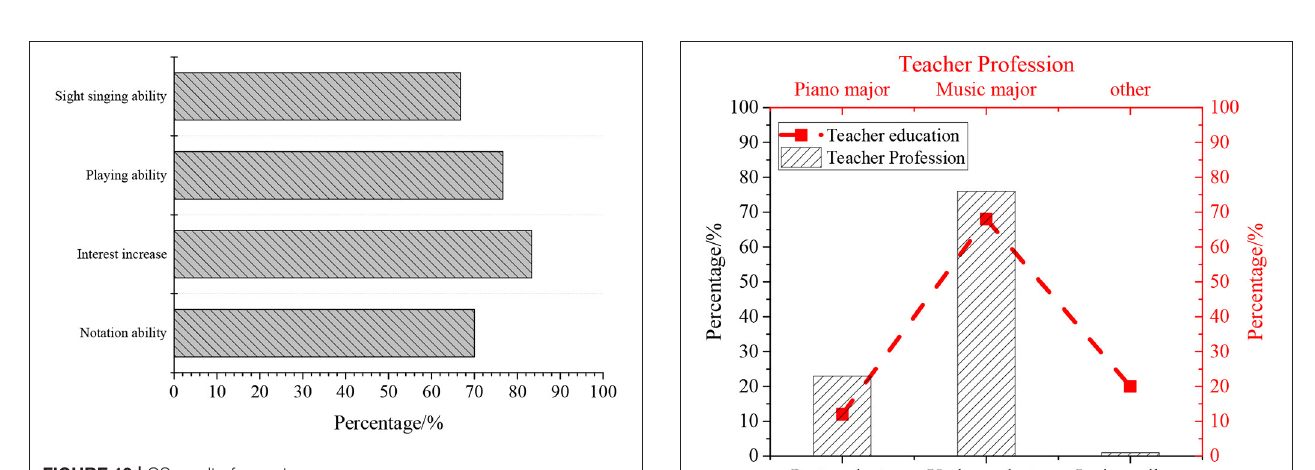
FIGURE 10 | QS result of parents.